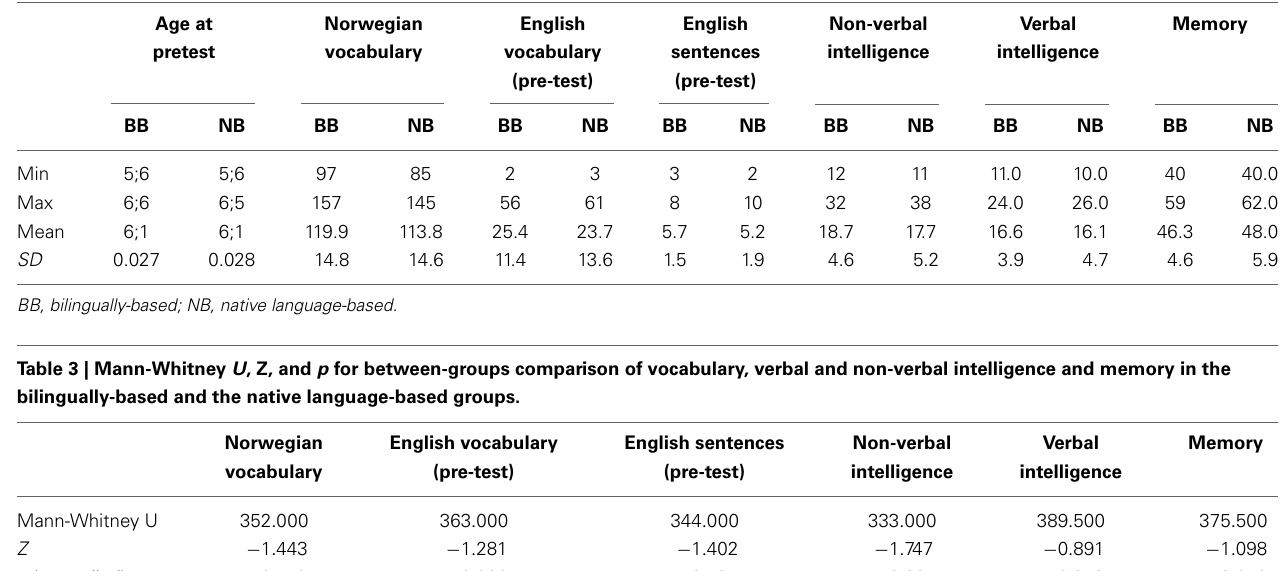
Table 2 | Mean, minimum and maximum values and standard deviations ( SD ) for age, vocabulary, verbal and non-verbal intelligence and memory scores (raw) in the bilingually-based and the native language-based groups.